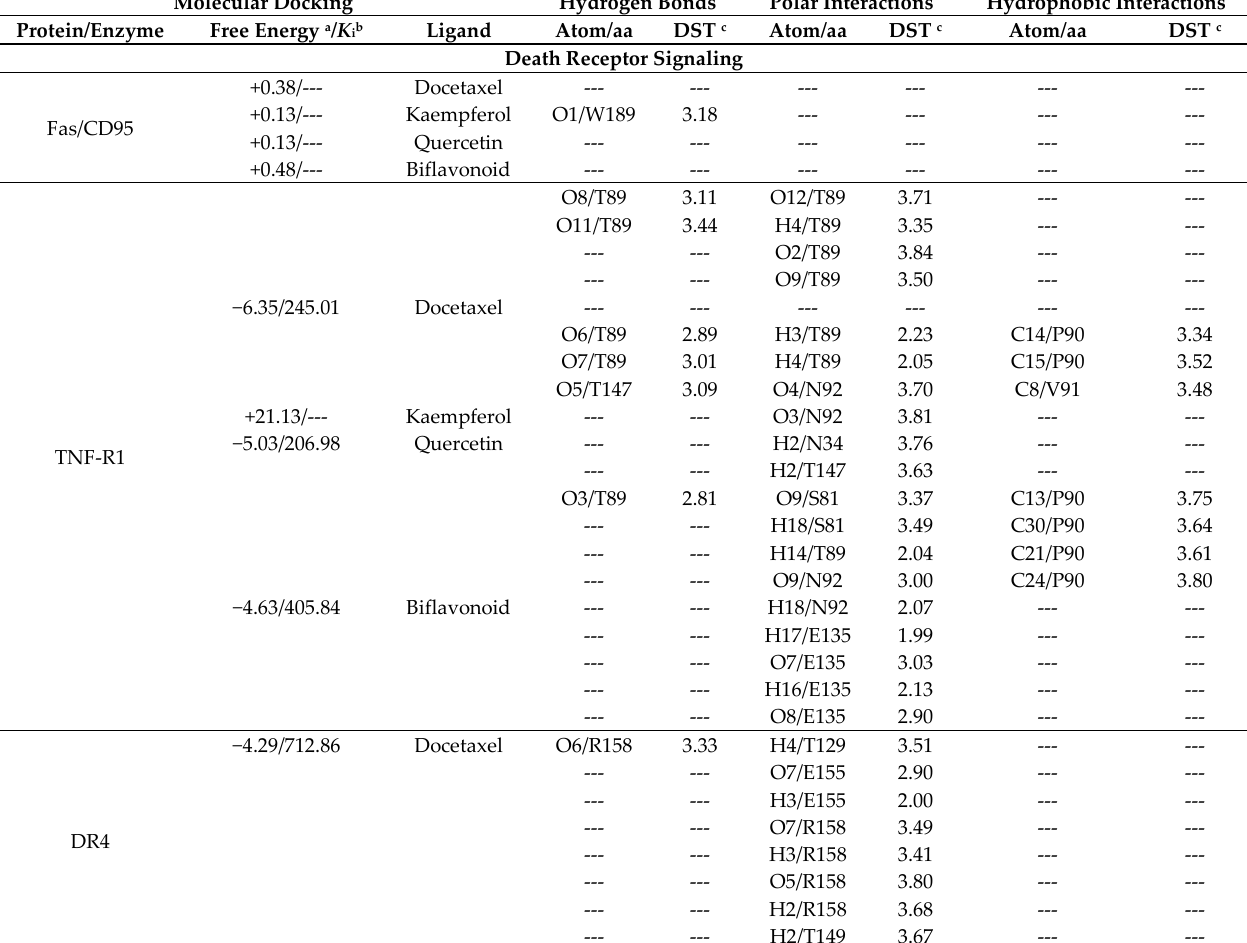
Table 5. Summary of free energy, inhibition constant ( K i ) and molecular interactions from metabolites determinate in fraction extract of A. lechuguilla .